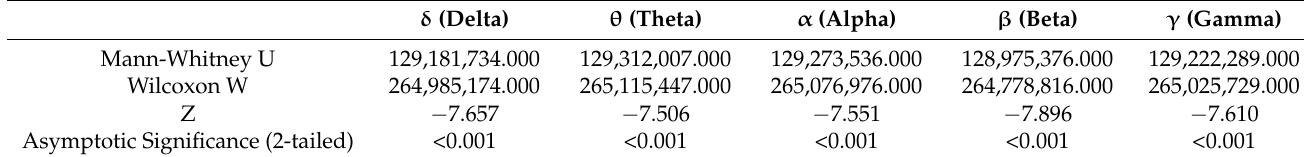
Table A10. Test Statistics for Mann-Whitney U Tests conducted on the Movement VDEP.